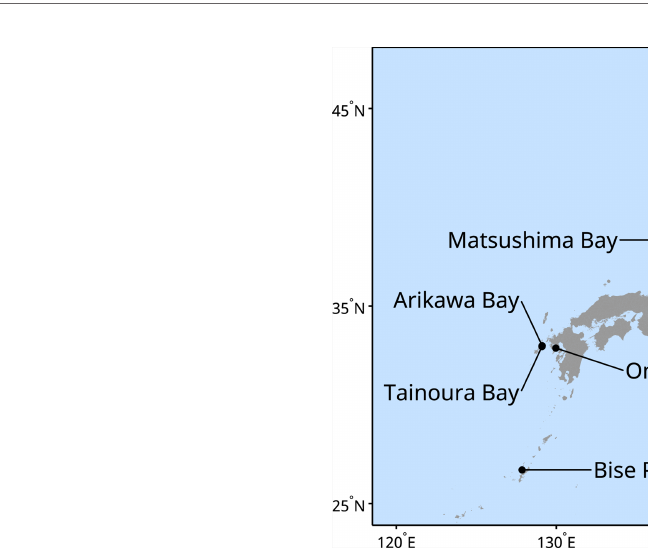
( Table 1 ). The period of seaweed production is variable and occurs for less than 6 months of the year. Variations in the species and the differences in the environmental conditions.